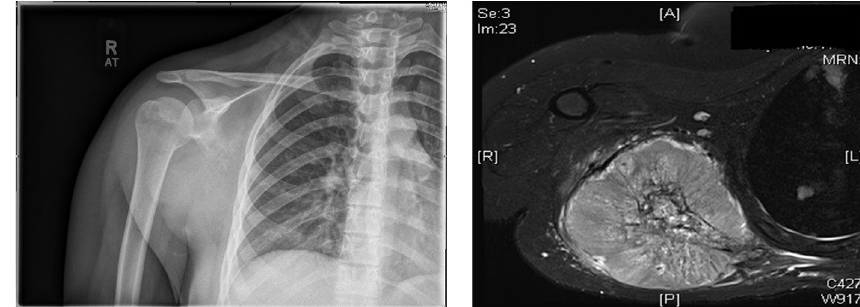
Figure 4. Plain radiograph demonstrating a destructive lesion of the right scapula confirmed with axial view of MRI scan showing a large soft tissue component to the scapular lesions consistent with Ewing’s